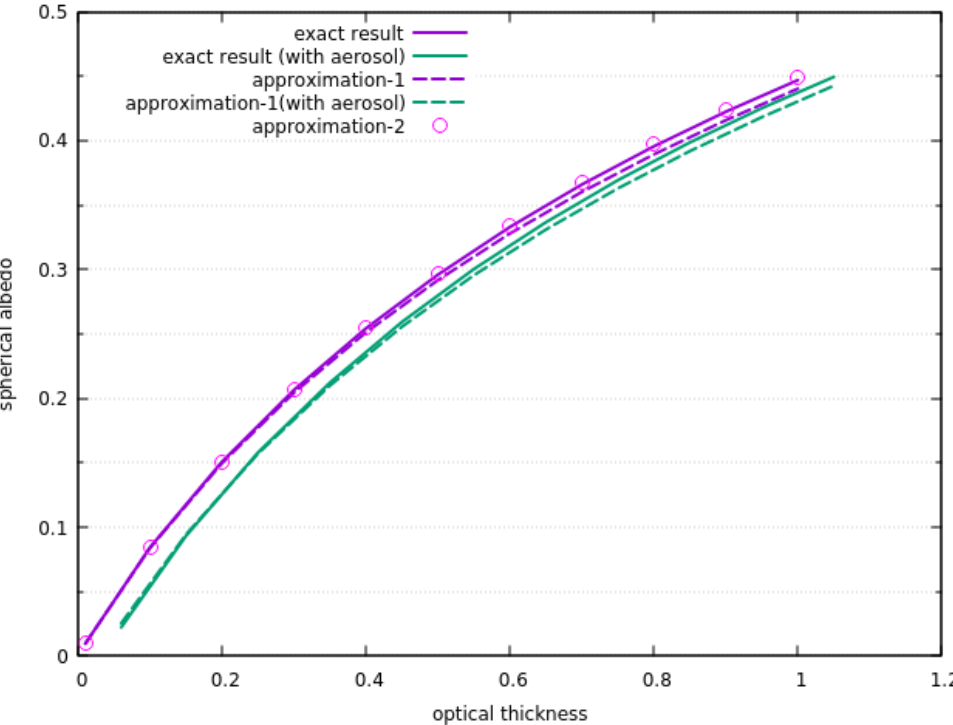
Figure 1. The intercomparison of different approximations for the calculation of the spherical albedo of atmosphere with molecular scattering with different values of atmospheric optical thickness. The exact RT calculations have been performed using the SORD code [26].